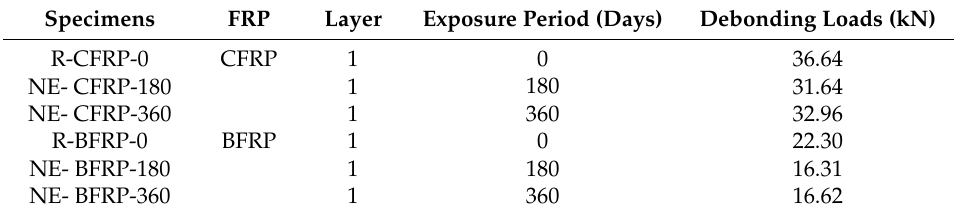
Table 2. Details of specimens and test